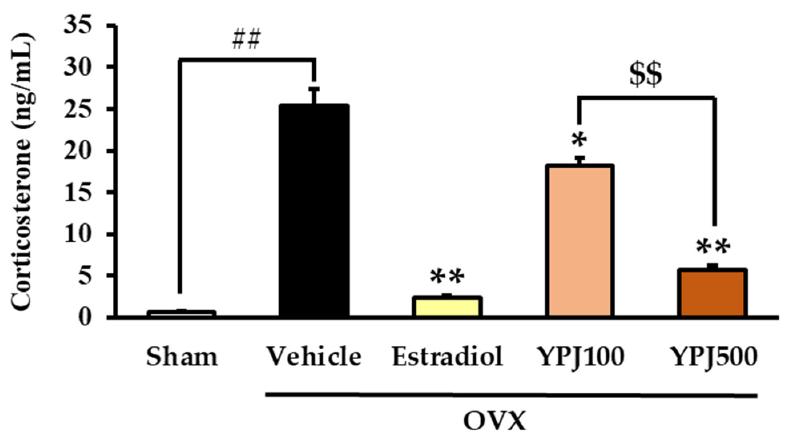
Figure 4. Effect of YPJ and 17 β -estradiol treatment on serum CORT levels in OVX mice. Each column represents the mean ± S.E.M. ( n = 5). ## p < 0.01 vs. the vehicle-treated sham group. * p < 0.05, ** p < 0.01 vs. the vehicle-treated OVX mice. $$ p < 0.01 compared between doses of YPJ formula (post hoc Tukey test).